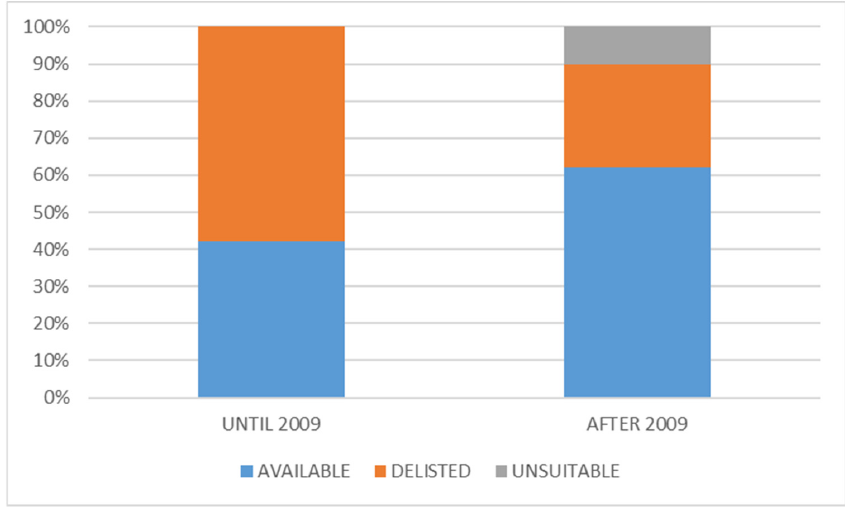
Figure 2. Data availability until and after 2009.